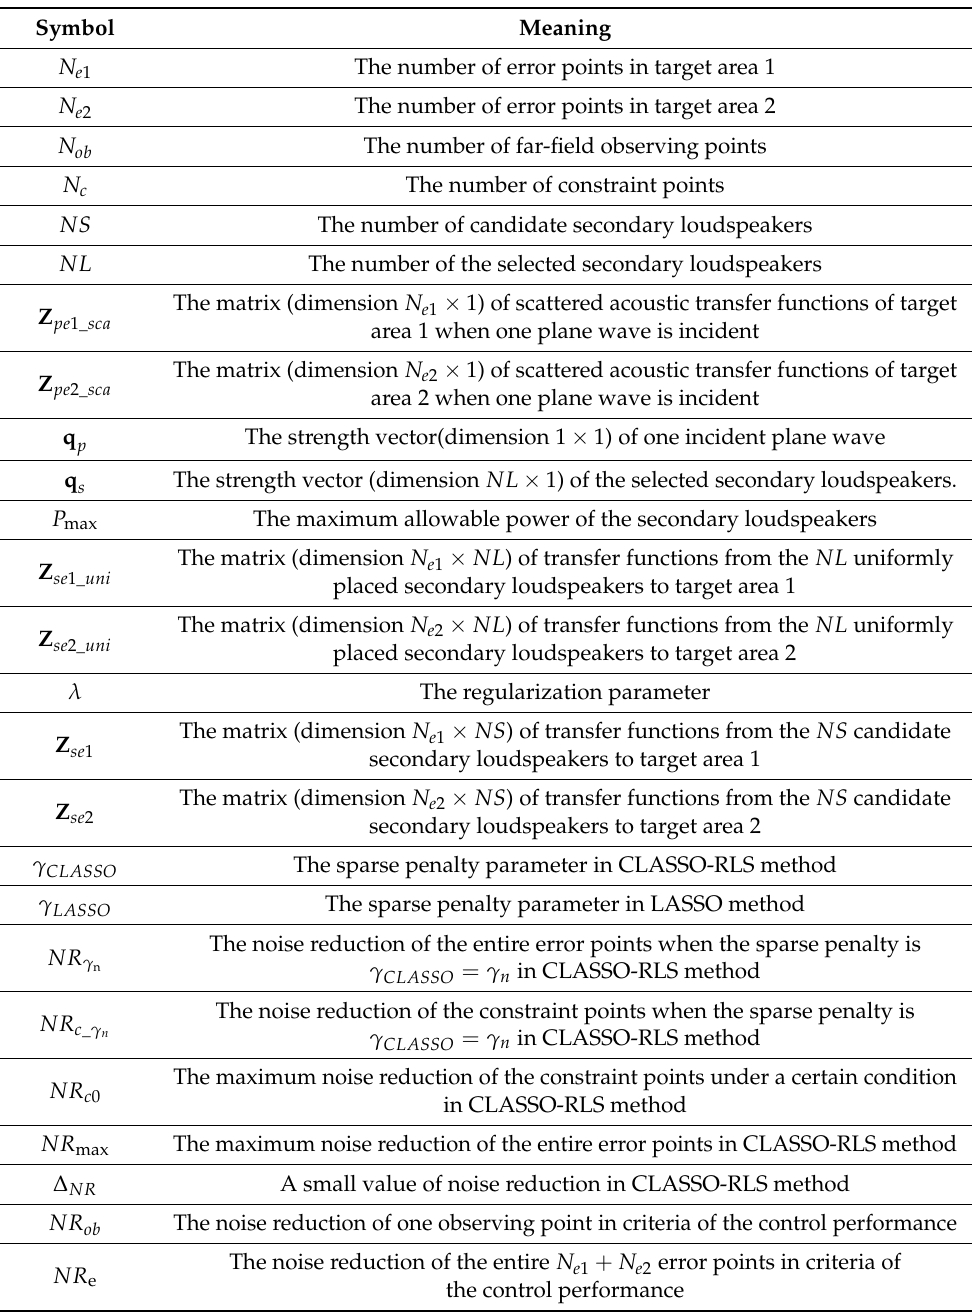
Table A1. Main symbols in the